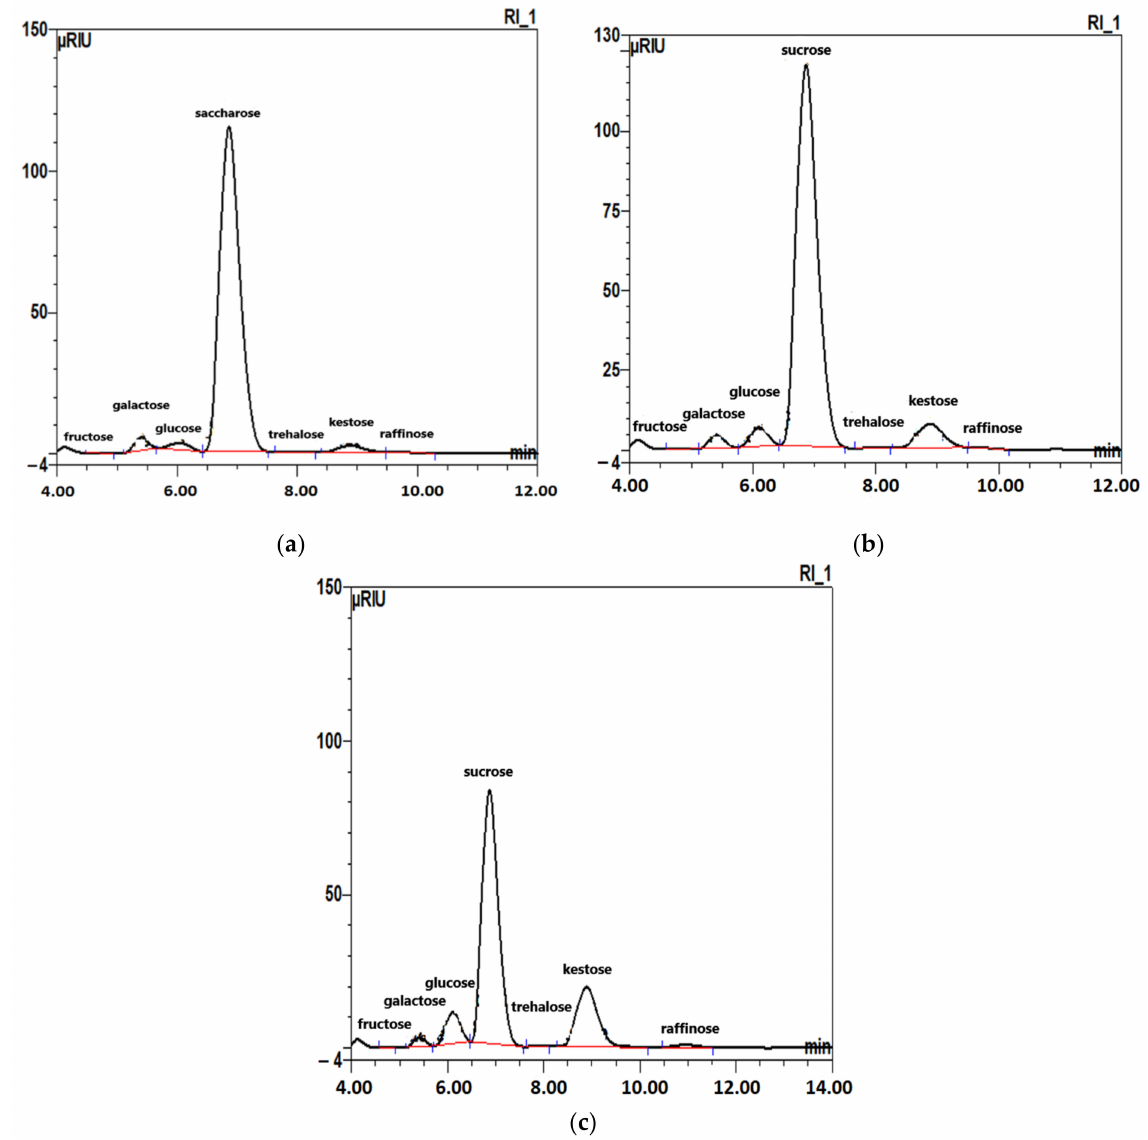
Figure 1. HPLC chromatograms of free carbohydrates in sugar beet roots: ( a ) fresh roots; ( b ) roots stored in uncovered mounds (beet clamps) for three months; ( c ) roots stored for three months in covered (rain and snow-proof)